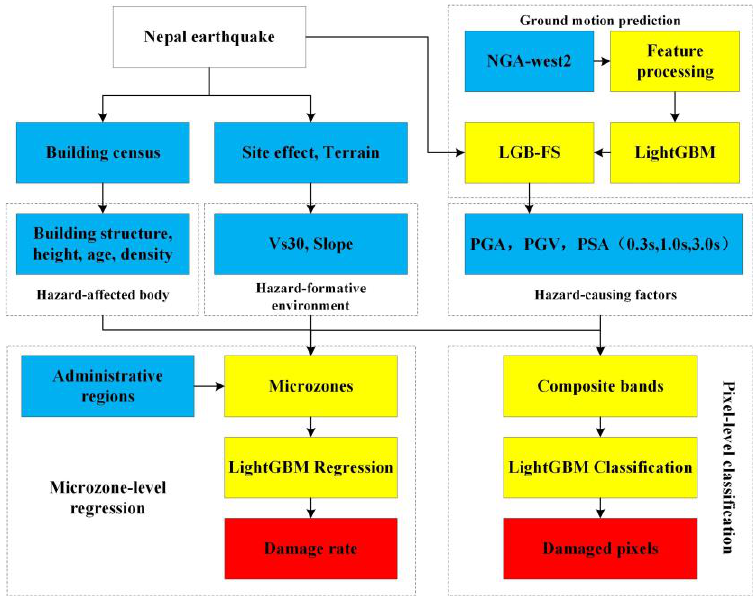
Figure 1. Technical flow chart. The blue rectangles represent data, the yellow rectangles represent method or processing operations, and the red rectangles represent the desired result.